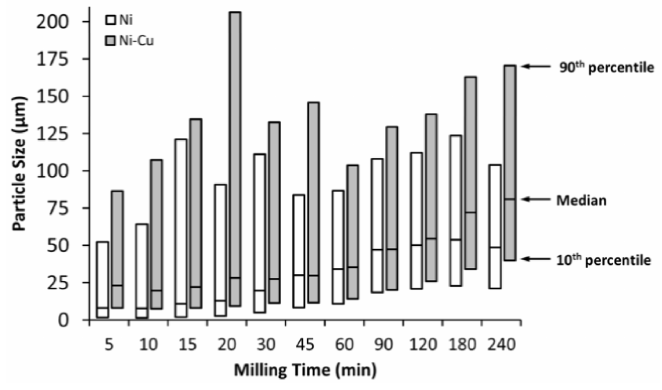
Figure 10. The particle size of Ni and Ni 30 at % Cu powders are compared over milling times from 5 min to 240 min.